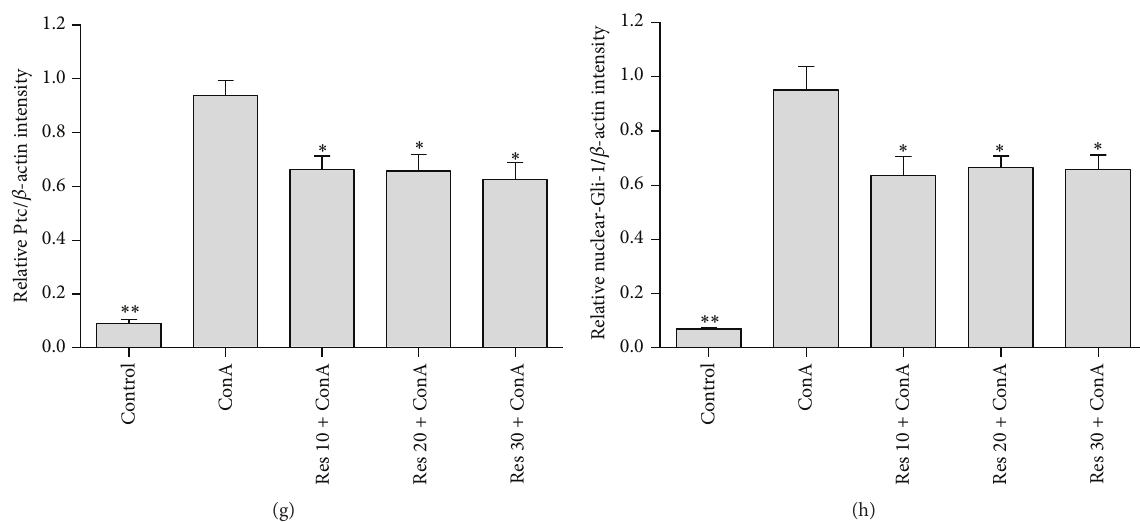
Figure 2: The western blot analysis of IL-2, IL-6, TNF- 𝛼 , Shh, Gli-1, and Ptc after ConA injection in mice and the effects of low (10mg/kg), medium (20mg/kg), and high (30 mg/kg) dose resveratrol pretreatment groups at the same